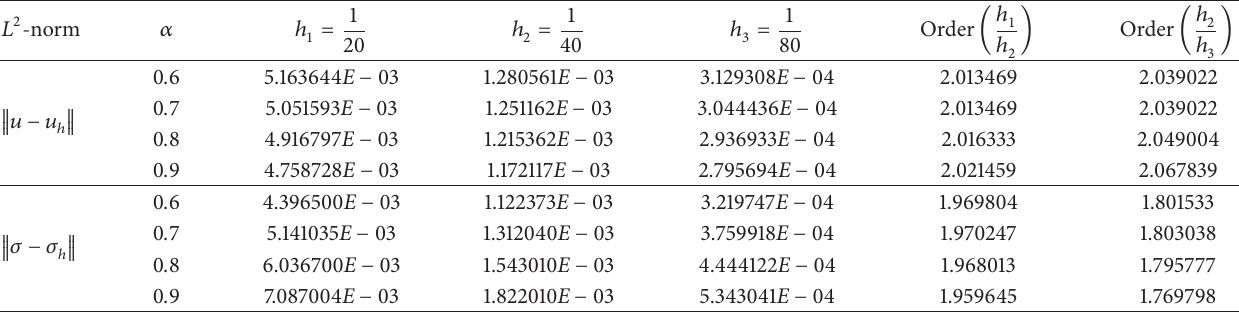
Table 1: Spatial convergence results in 𝐿 2 -norm with fixed Δ𝑡 = 1/4000 and changed 𝛼 .